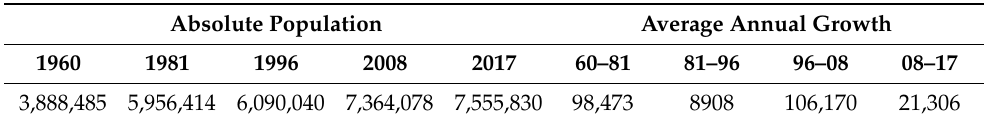
Table 13. Population growth, absolute numbers and cumulative annual growth in Catalonia.